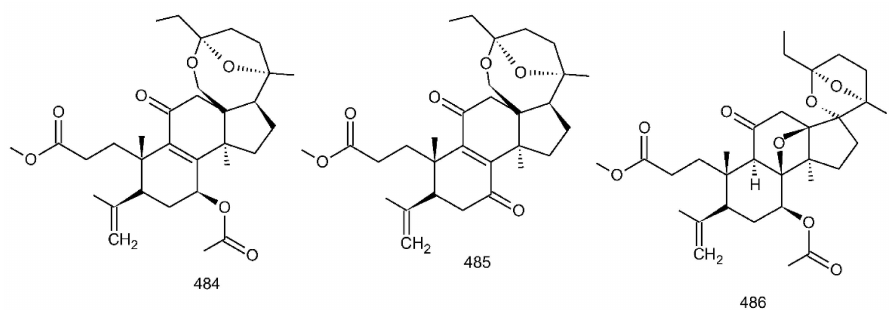
Figure 31. Chemical structures of several rearranged novel triterpenoids ( 484 – 486 ). Ganoapplanic acids A ( 487 ) and B ( 488 ) (Figure 32) are two rearranged lanotane- type triterpenoids isolated from G. applanatum with a 6/6/5/6-fused tetracyclic skeleton. Ganoapplanic acid B ( 488 ) represents the first example of a rearranged triterpenoid